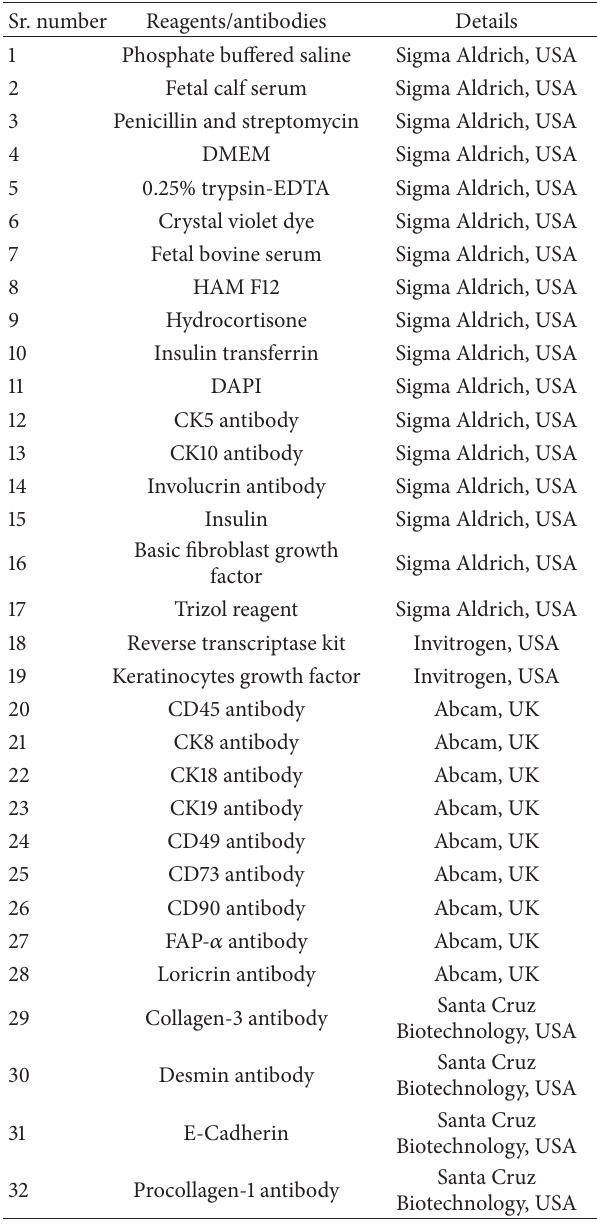
Table 2: List of reagents and antibodies. Sr.